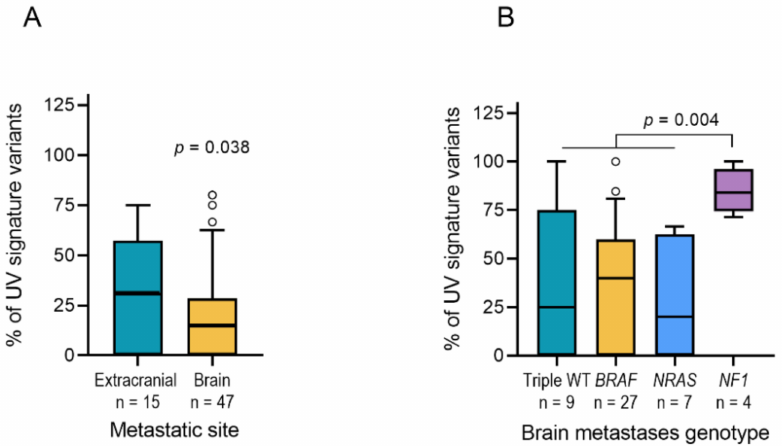
Figure 4. ( A ) Box and whiskers plot showing the frequency of C > T/G > A UV mutation signature in extracranial and brain metastatic tissues including unpaired samples. p -value indicates two-sided unpaired t -test. ( B ) Box and whiskers plot showing the frequency of C > T/G > A UV mutation signature across mutational subtypes of brain metastases. p -value from two-sided unpaired t